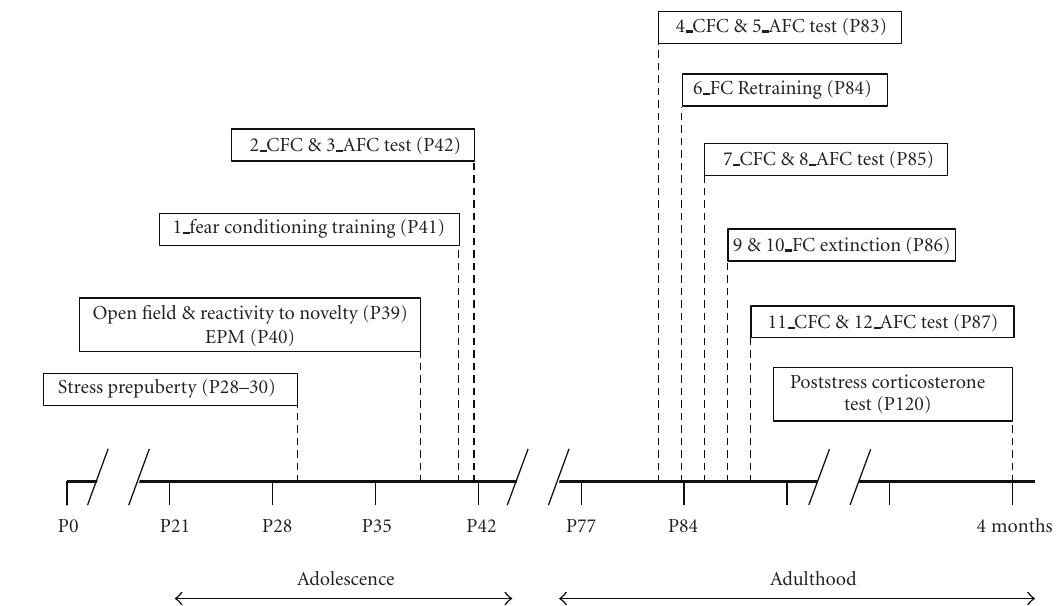
Figure 1: Stress and behavioral test procedures. “P” indicates the postnatal day. CFC: contextual fear conditioning test; AFC: auditory fear conditioning